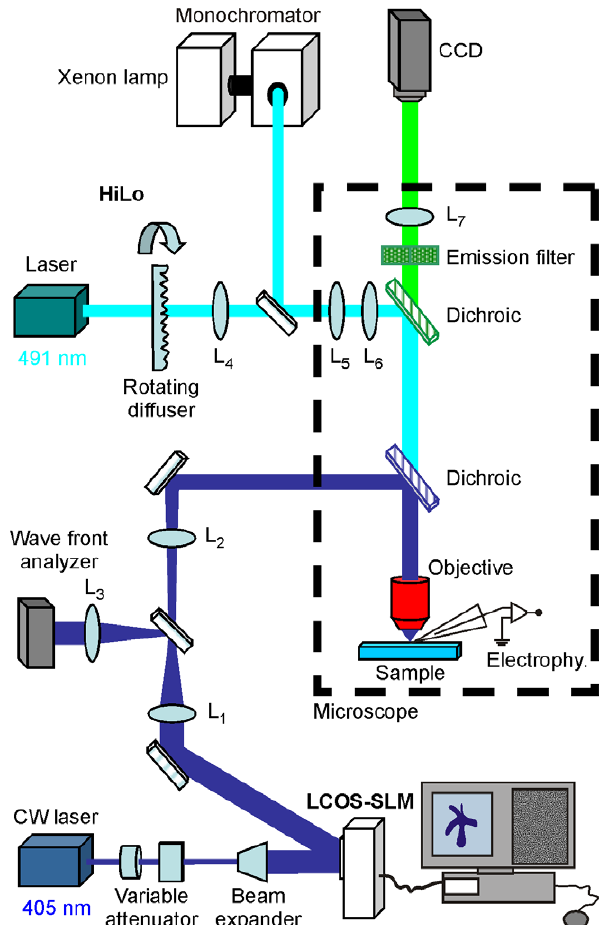
Figure 1. Optical set-up for holographic illumination. Layout of the optical set-up. The focal length of the lenses are f 1 =750 mm, f 2 =500 mm, f 3 =200 mm, f 4 =75 mm. See methods for details.